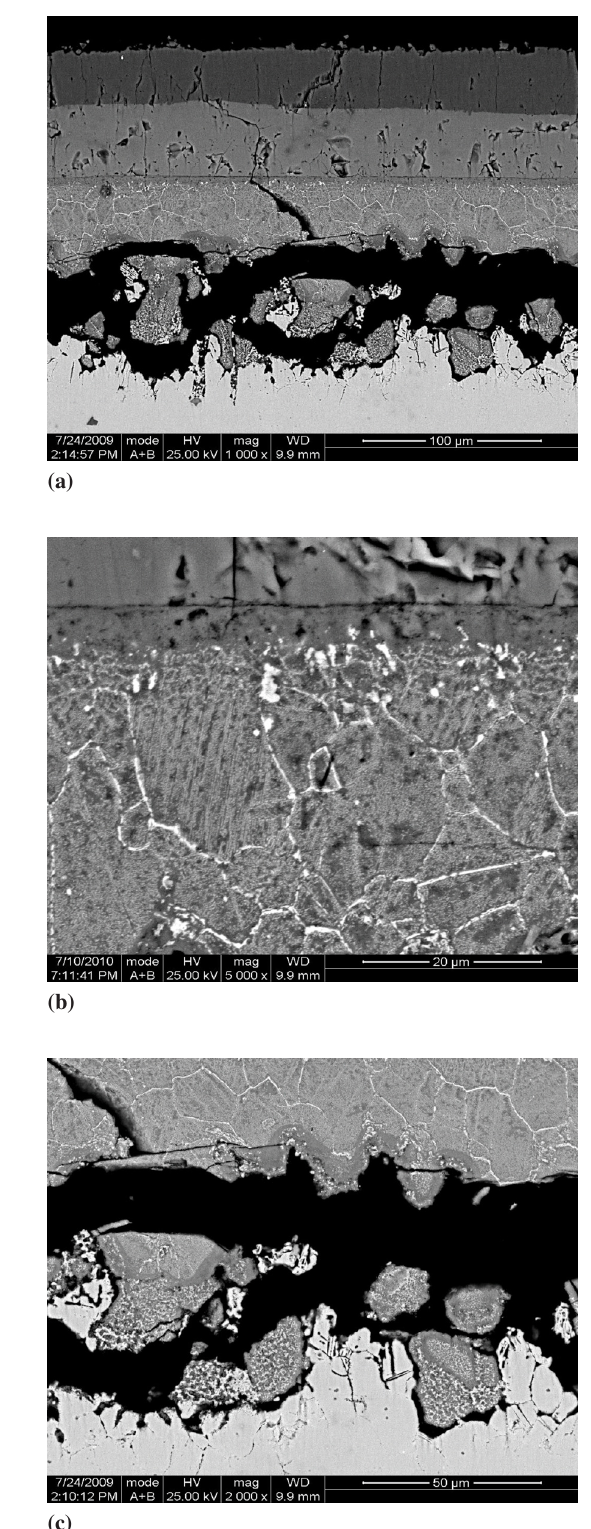
Figure 7. cross-sectional morphologies of 304 SS corroded at 973 K in (Li,Na,K) 2 CO 3 -(Na,K)Cl for 500 h. (a) general view; (b) and (c) the amplified views of the inner layer of (a).